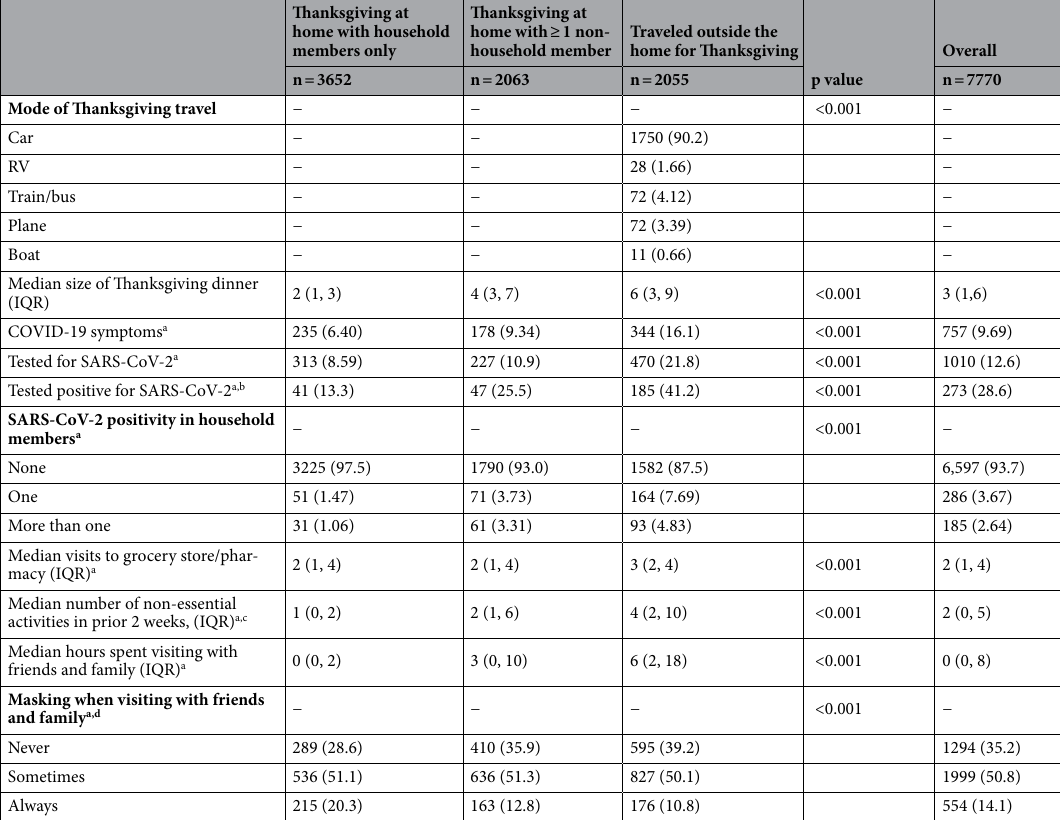
Table 2. Thanksgiving travel, activity and SARS-CoV-2 testing history among 7770 adults sampled across 10 US states from December 4–18, 2020. Numbers may not sum to total if there were participants who elected not to answer a given question. P values from Kruskal–Wallis tests for continuous variables and chi-squared tests for categorical variables using unweighted estimates. IQR, interquartile range. a Reflect behaviors in the